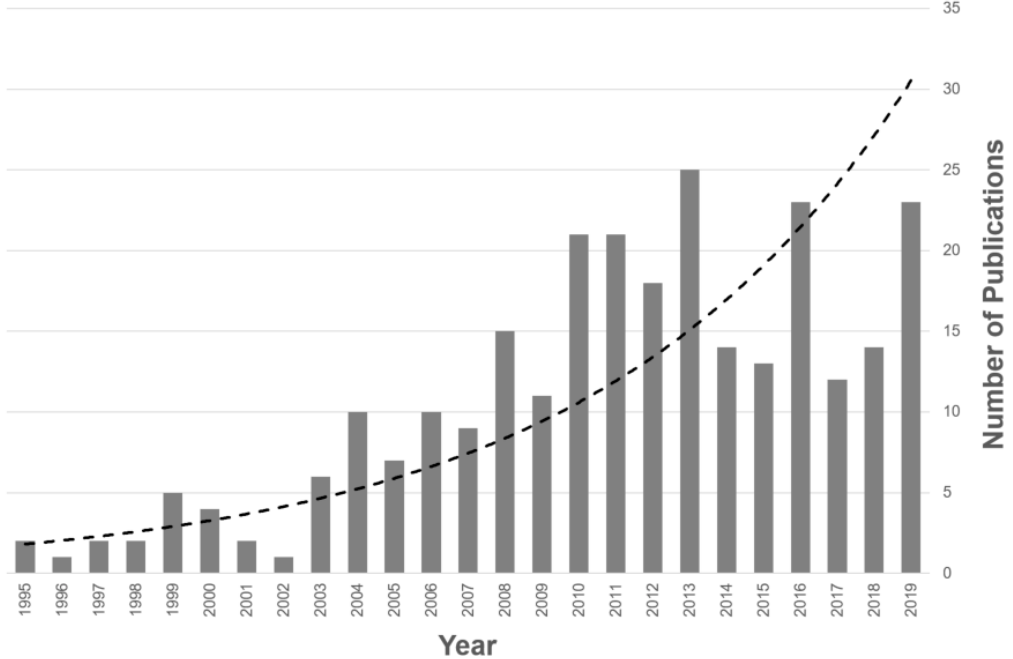
Figure 2. The number of volcano-related publications per year that have incorporated ASTER data in some aspect of the work. Through 2016, the growth has been roughly exponential (dashed line). That growth has declined somewhat in the last several years, although still remaining respectable. The total number of publications shown is 271, spanning the last 25 years.